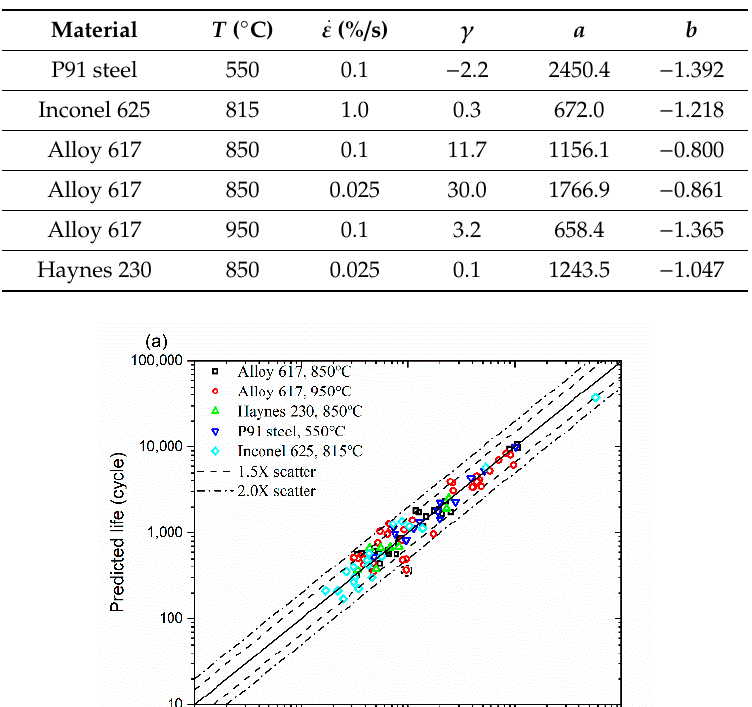
Figure 5. The relation between fatigue life and total tensile strain energy density of Inconel 625. Table 3. Model constants in the present model.